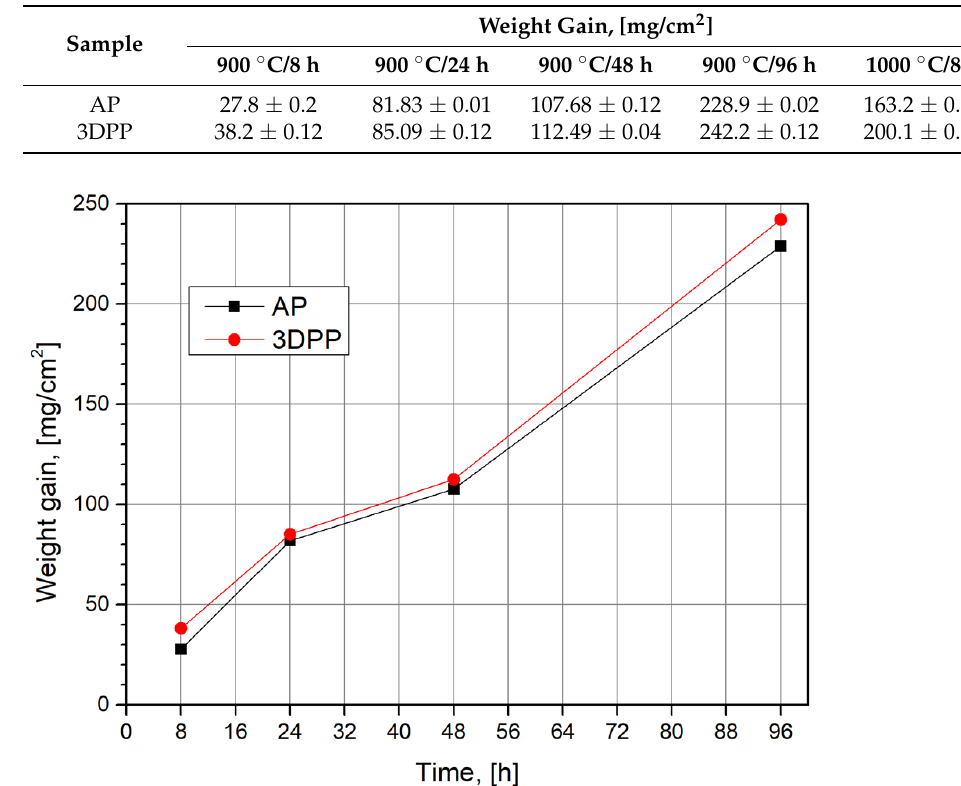
Table 2. Weight gain of specimens after hot corrosion tests (±SD).